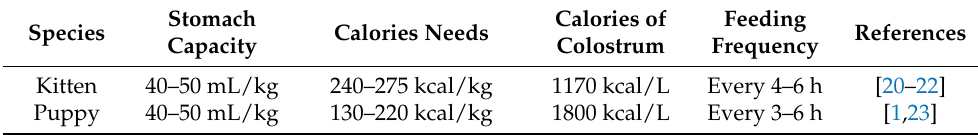
Table 1. Scheme of colostrum administration and energy requirements of puppies and